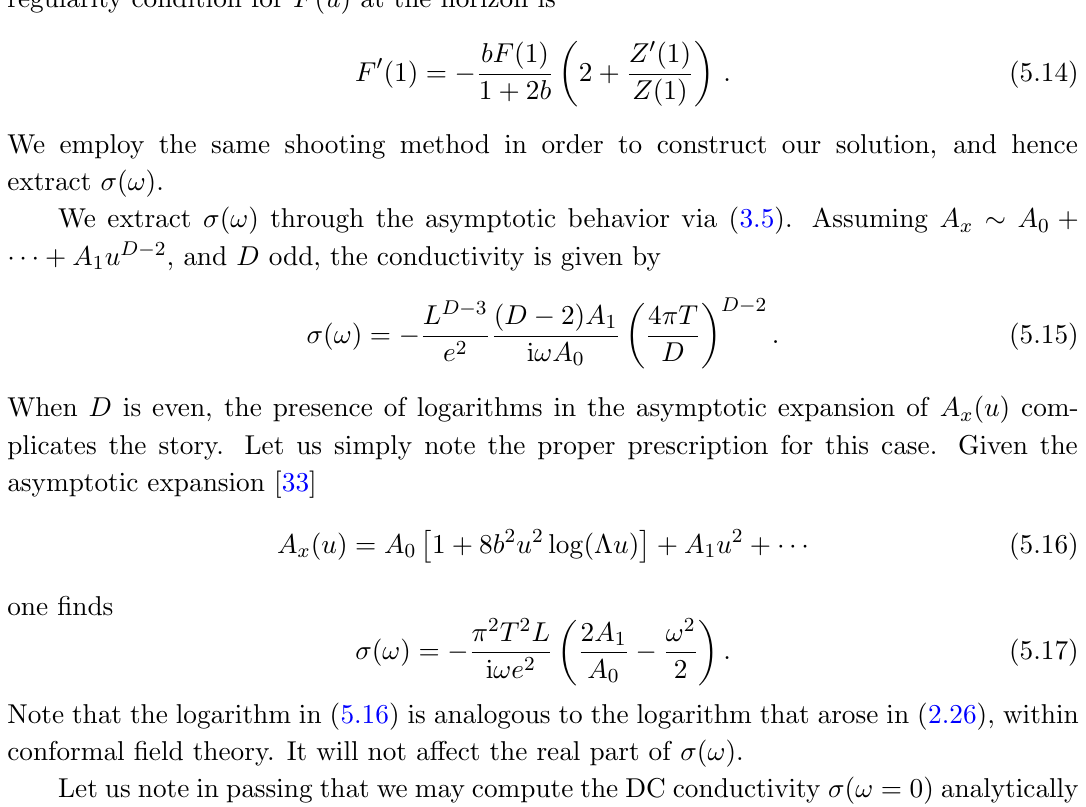
Figure 3 . Scalar two point function dimensions (cid:1) 0 = 2 and (cid:1) = 2. We have set (cid:11) Y (cid:11) W = 1. Left: full frequency response for the scalar two point function. Right: comparison between the analytic prediction for the leading correction to the linear response plotted against the numerically calculated response with the leading term removed (plotted in a log-log